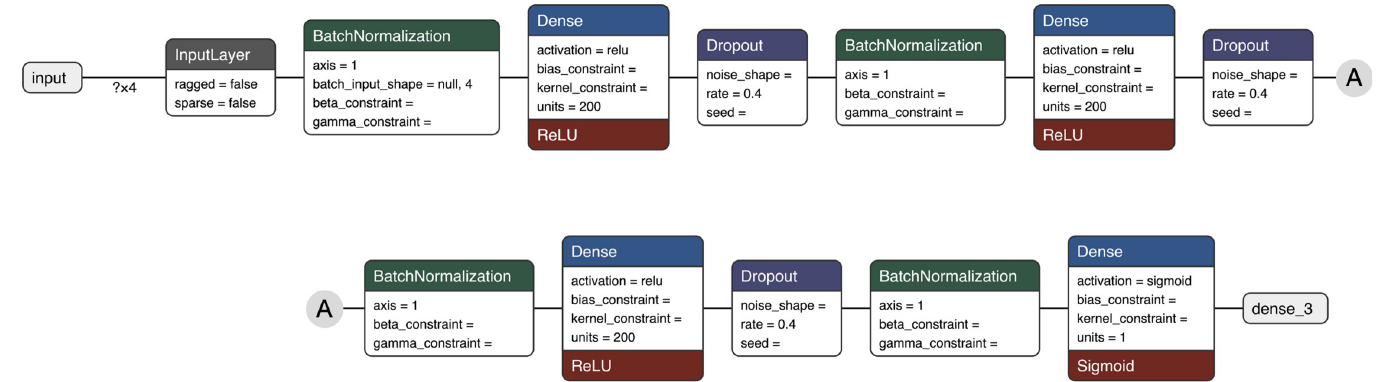
Fig 6. The neural network architecture for the feature identifiability classifier.